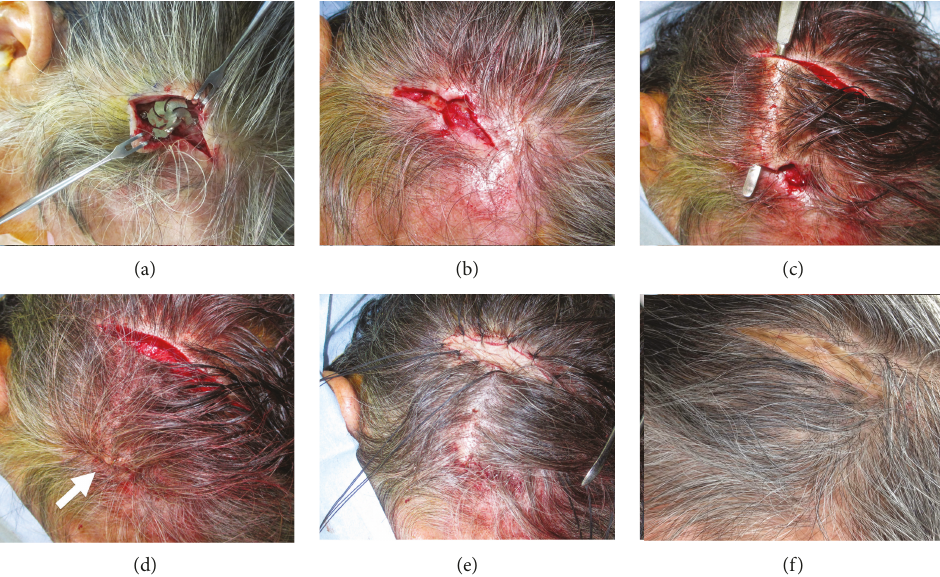
Figure 2: Surgical treatment. (a) A skin incision has been made above the titanium plate to expose it. (b) The plate and all screws have been removed. (c) A relief skin incision has been made 6 cm posterior to the skin defect to enable (d) suturing of the defect without causing tension (white arrow). (e) The scalp defect caused by the relief incision portion has been covered with skin graft from the outer layer of skin of the right thigh. (f) Two months after the surgery, the skin incision has healed without infection and the skin graft has been successfully